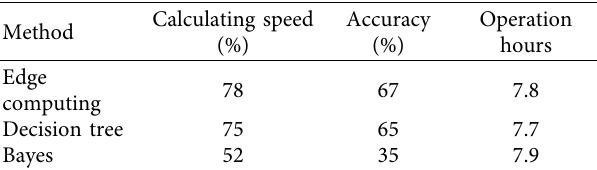
Figure 9: System power consumption for three-tier processing architecture and two-tier processing architecture at the same system utility. (a) System power consumption of two-tier processing architecture. (b) System power consumption of three-tier processing architecture. Table 5: Three-tier processing architecture, decision tree, and Bayesian comparison test table based on edge